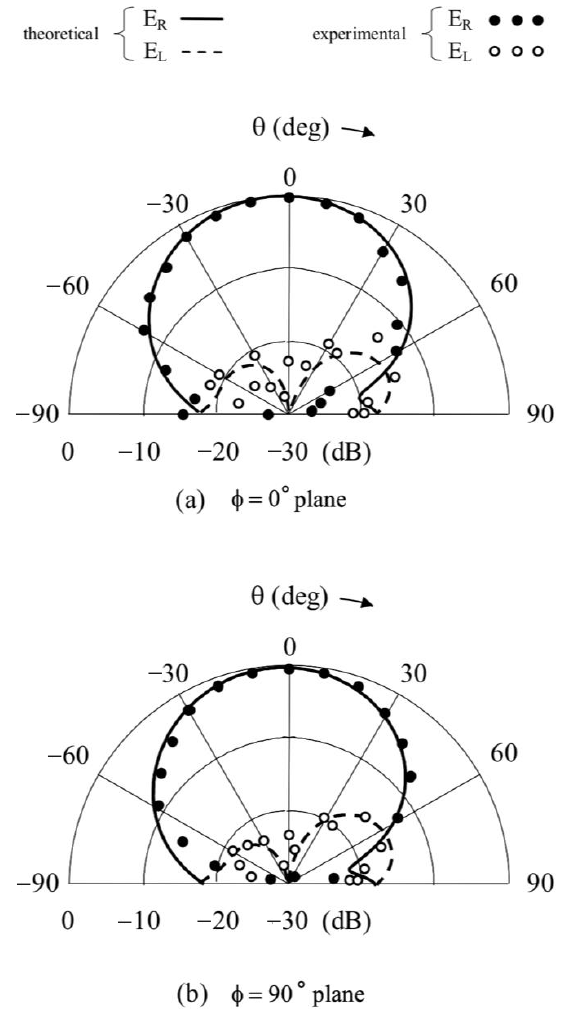
Figure 9. Radiation patterns of a curl antenna at f = 0.993 f 0 .